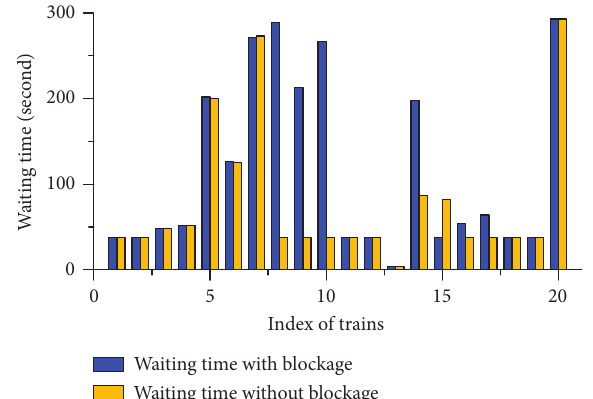
Figure 15: Waiting time of each train in front of station C.